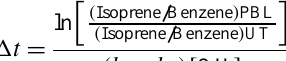
Fig. 10. Total NMHC reactivity according to OH radical in the boundary layer (LT, in red, 58 data points) and in the UT during non-convective (NC.UT in orange, 20 data points) and convective (C.UT, in yellow, 29 data points) situations.